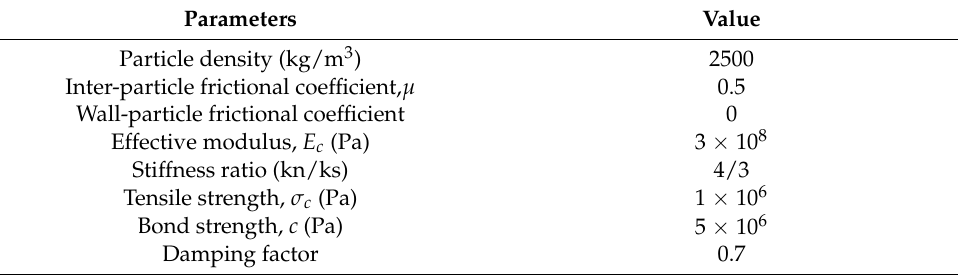
Table 2. Parameters used in the DEM